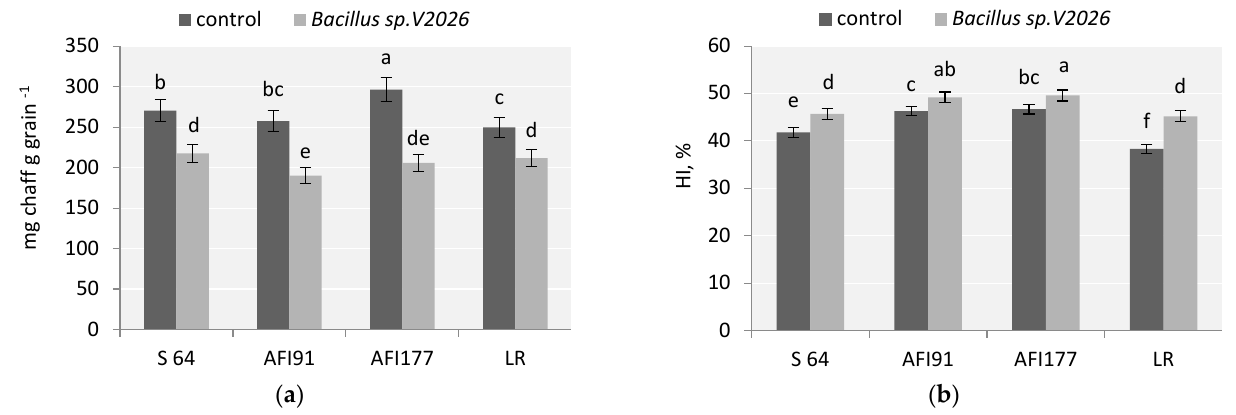
Figure 1. Effect of inoculation with Bacillus sp. V2026 on chaff to grain ratio ( a ) and harvest in- dex (HI) ( b ). The bars are means of two experiments with 50 biological replications per variant. Bars show ± SEM, and different letters (a–f) show a significant difference at the p ≤ 0.05 level, as determined by Duncan’s multiple test.